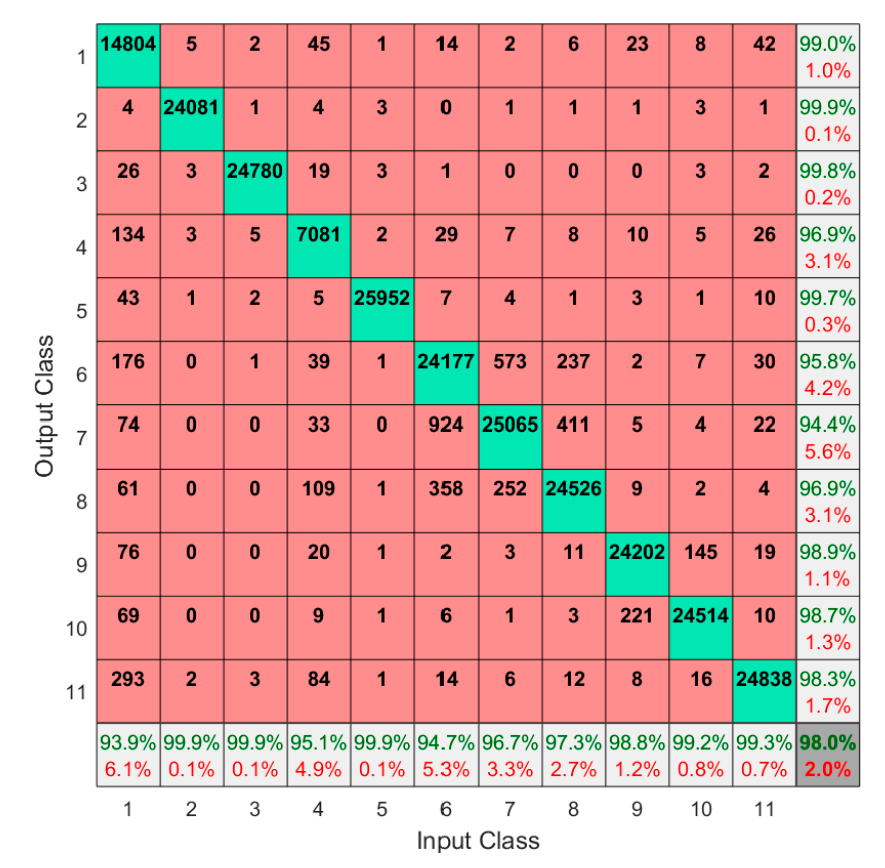
Figure 2. Confusion matrix when using the K-NN method at the group level (i.e., all participants), using input from both SSs and SUS (i.e., the complete STS). Input and output classes correspond to the 11 simulated physical activities. Cells on the main diagonal (green color) and off-diagonal (red color) indicate the numbers of correctly and incorrectly classified observations of each activity, respectively. Cells in the right-hand column provide the percentages of precision (green font) and false discovery rate (red font) for each activity. Cells in the lowest row provide the percentages of both sensitivity (green font) and false negative rate (red font) for each activity. The cell at the bottom-right corner (gray color) provides global